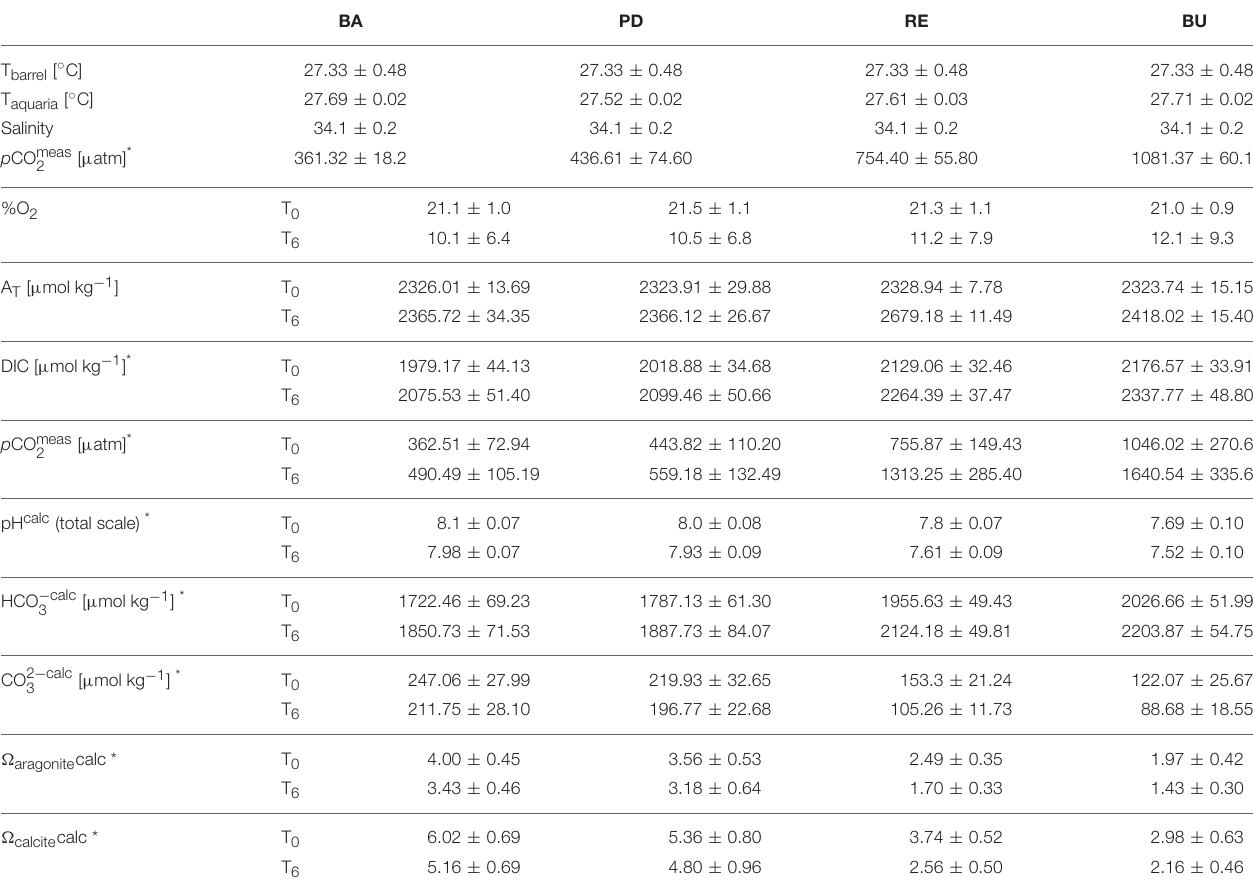
TABLE 1 | Seawater physical and carbonate chemistry parameters at the start (T 0 ) and the end (T 6 ) of incubation experiments, averaged ( ± standard deviation) over all incubations for each pCO 2